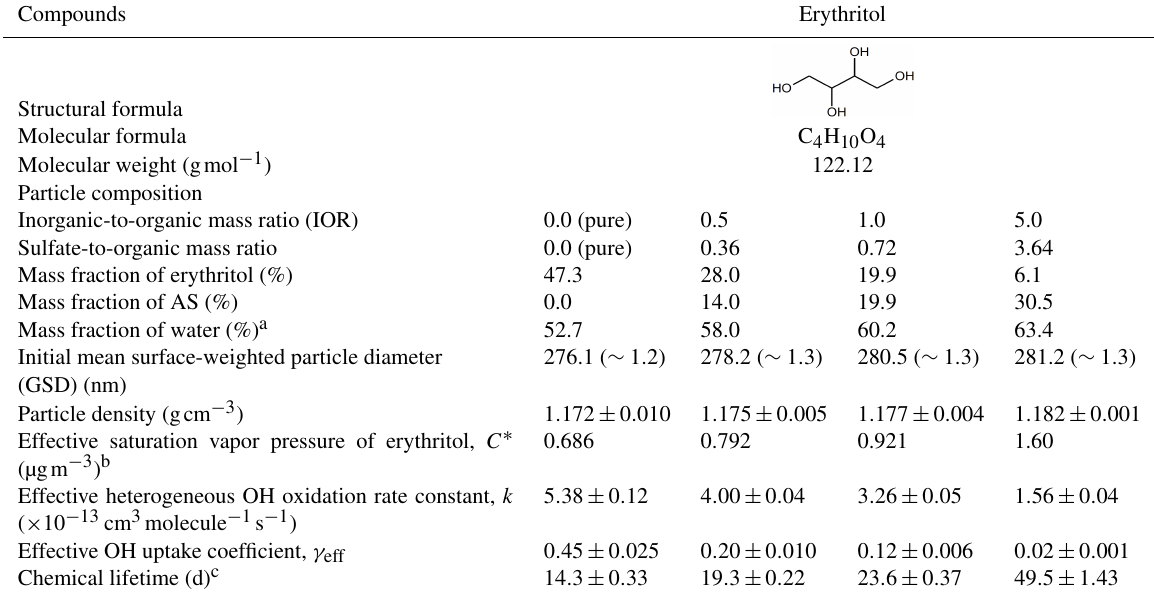
Table 1. Chemical structure, properties, effective rate constant and OH uptake coefficient of pure erythritol particles and erythritol–AS particles with different IORs at 85%